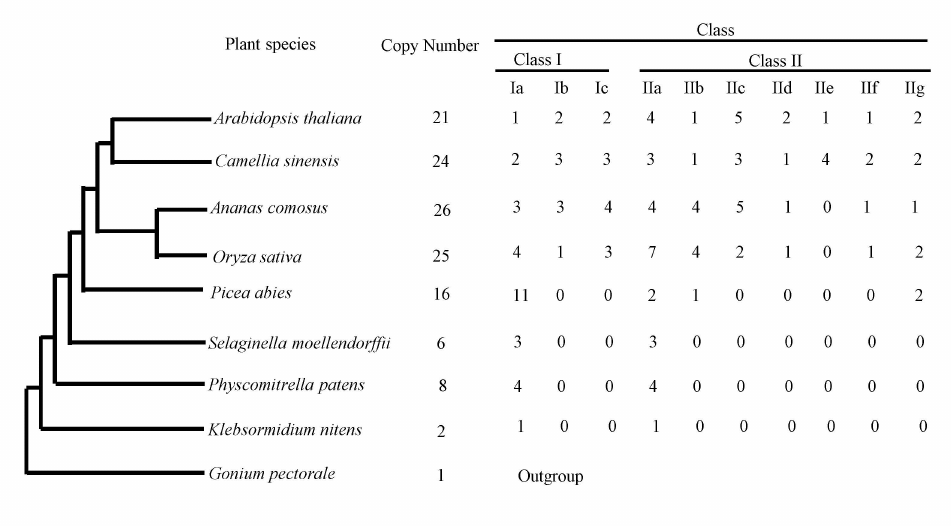
Figure 1. Summary of the heat shock transcription factor (Hsf) gene superfamily among 9